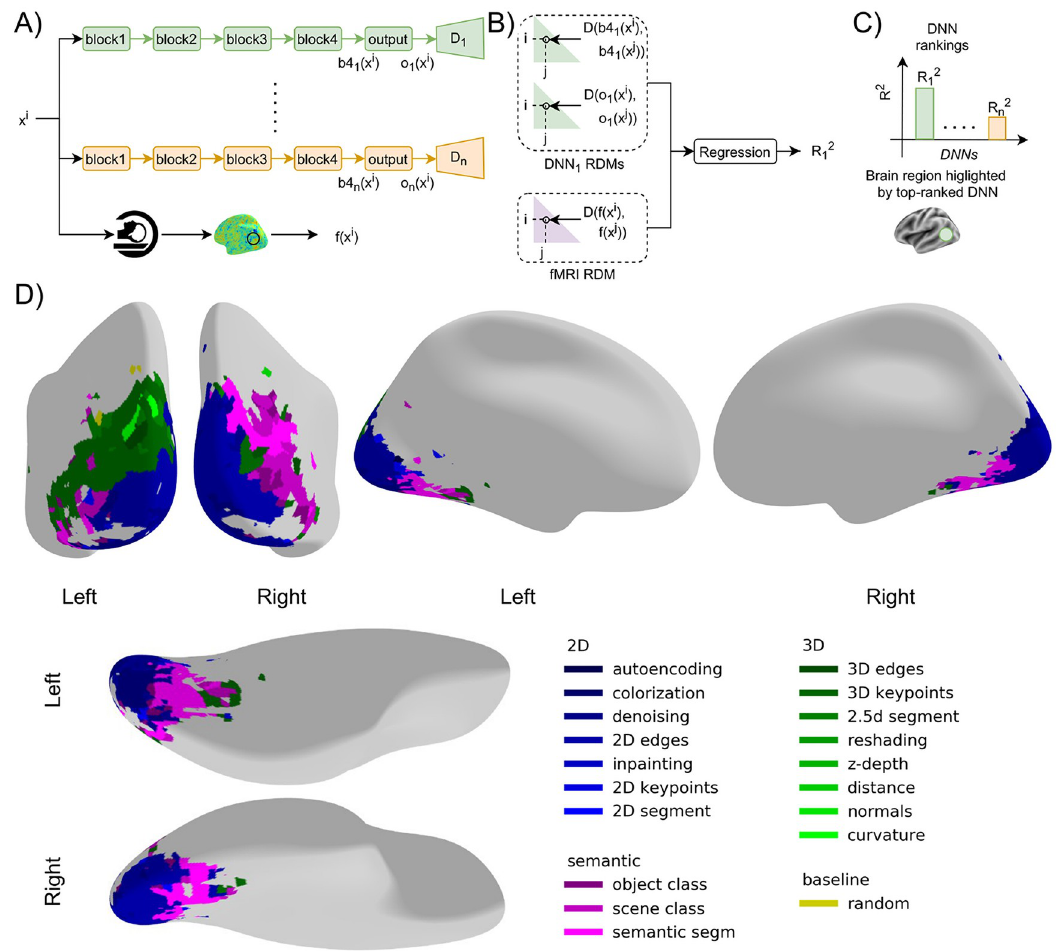
Fig 1. Methods and results of functional mapping of the visual cortex by task-specific DNNs. A ) Schema of DNN-fMRI comparison. As a first step, we extracted DNN activations from the last two layers (block 4 and output) of the encoders, denoted as b4 1 (x i ), o 1 (x i ) for DNN 1 and b4 n (x i ), o n (x i ) for DNN n in the figure, from n DNNs and the fMRI response of a region f(x i ) for the i th image x i in the stimulus set. We repeated the above procedure for all the images in the stimulus set. B ) We used the extracted activations to compute the RDMs, two for the two DNN layers and one for the brain region. Each RDM contains the pairwise dissimilarities of the DNN activations or brain region activations, respectively. We then used multiple linear regression to obtain an R 12 score to quantify the similarity between DNN 1 and the brain region. We repeated the same procedure using other DNNs to obtain corresponding R 2 C ) We obtained a ranking based on R 2 to identify the DNNs with the highest R 2 for fMRI responses in that brain region. To visualize the results, we color-coded the brain region by the color indexing the DNN showing the highest R 2 in that brain region. D ) Functional map of the visual brain generated through a spatially unbiased searchlight procedure, comparing 18 DNNs optimized for different tasks and a randomly initialized DNN as a baseline. We show the results for the voxels with significant noise ceiling and R 2 with DNN (p < 0.05, permutation test with 10,000 iterations, FDR-corrected). An interactive visualization of the functional brain map is available in this weblink (https://sites.google.com/view/dnn2brainfunction/home#h.ub1chq1k42n6).